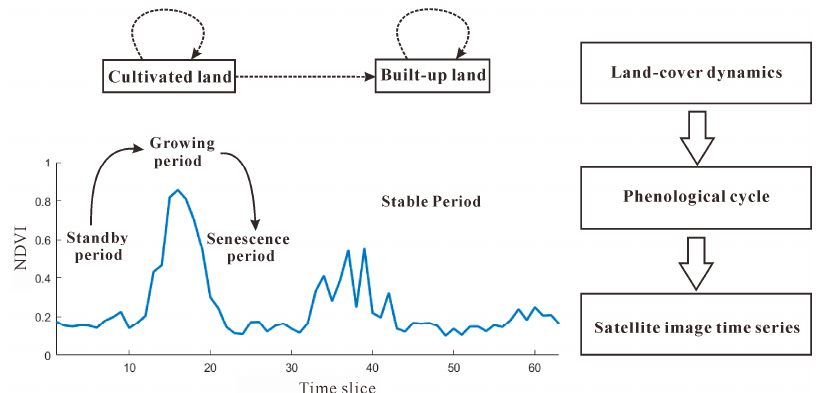
Figure 1. We deconstruct the urbanization process into three hierarchical layers, shown in the right figure. The top layer represents the annual land-cover dynamics, namely, stable cultivated land, cultivated land to built-up land, and stable built-up land. The middle layer represents the phenological cycles of vegetation growth for each land cover type. The bottom layer denotes the temporal evolution of spectral reflectance or spectral index.